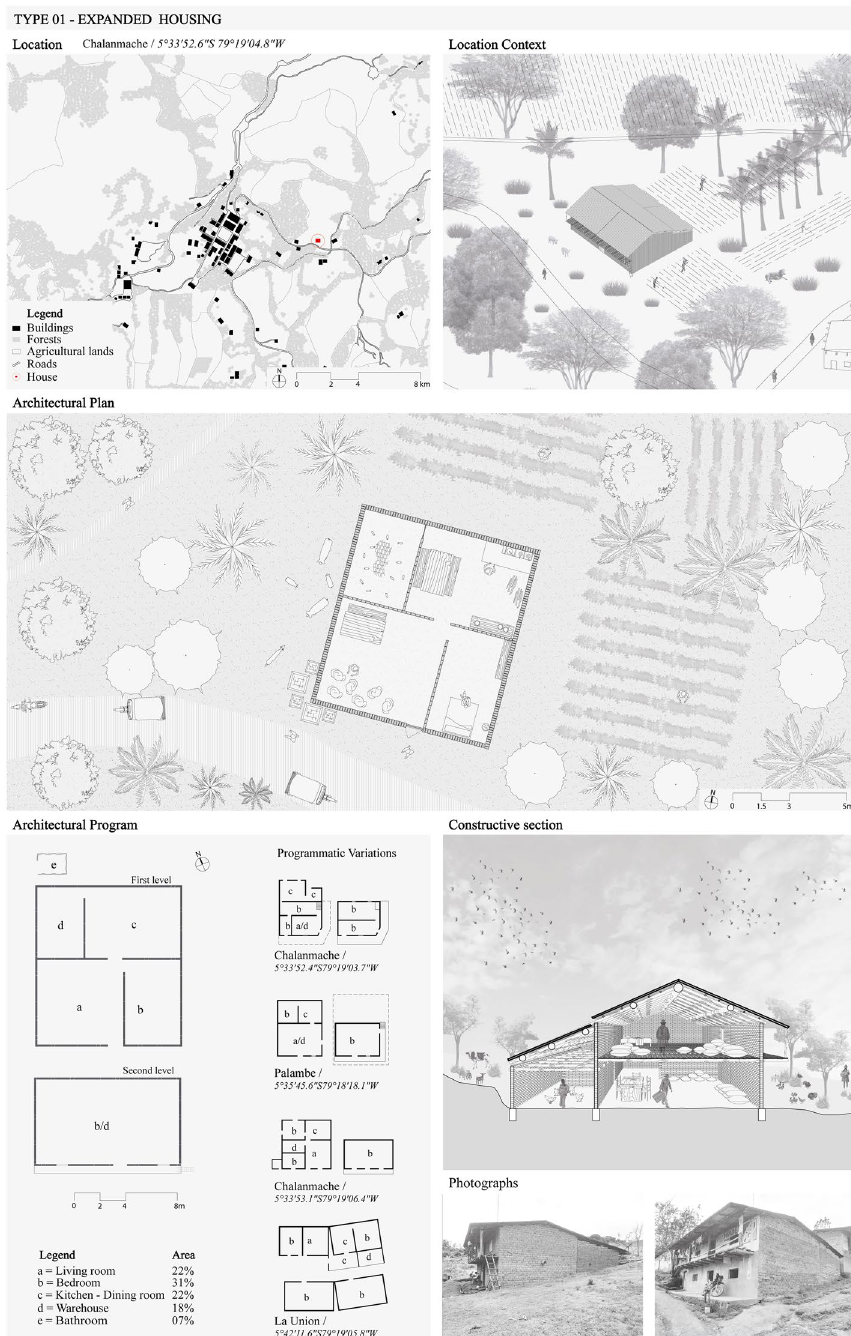
Fig. 2 Architectural characteristics of the expanded housing type (Source: the